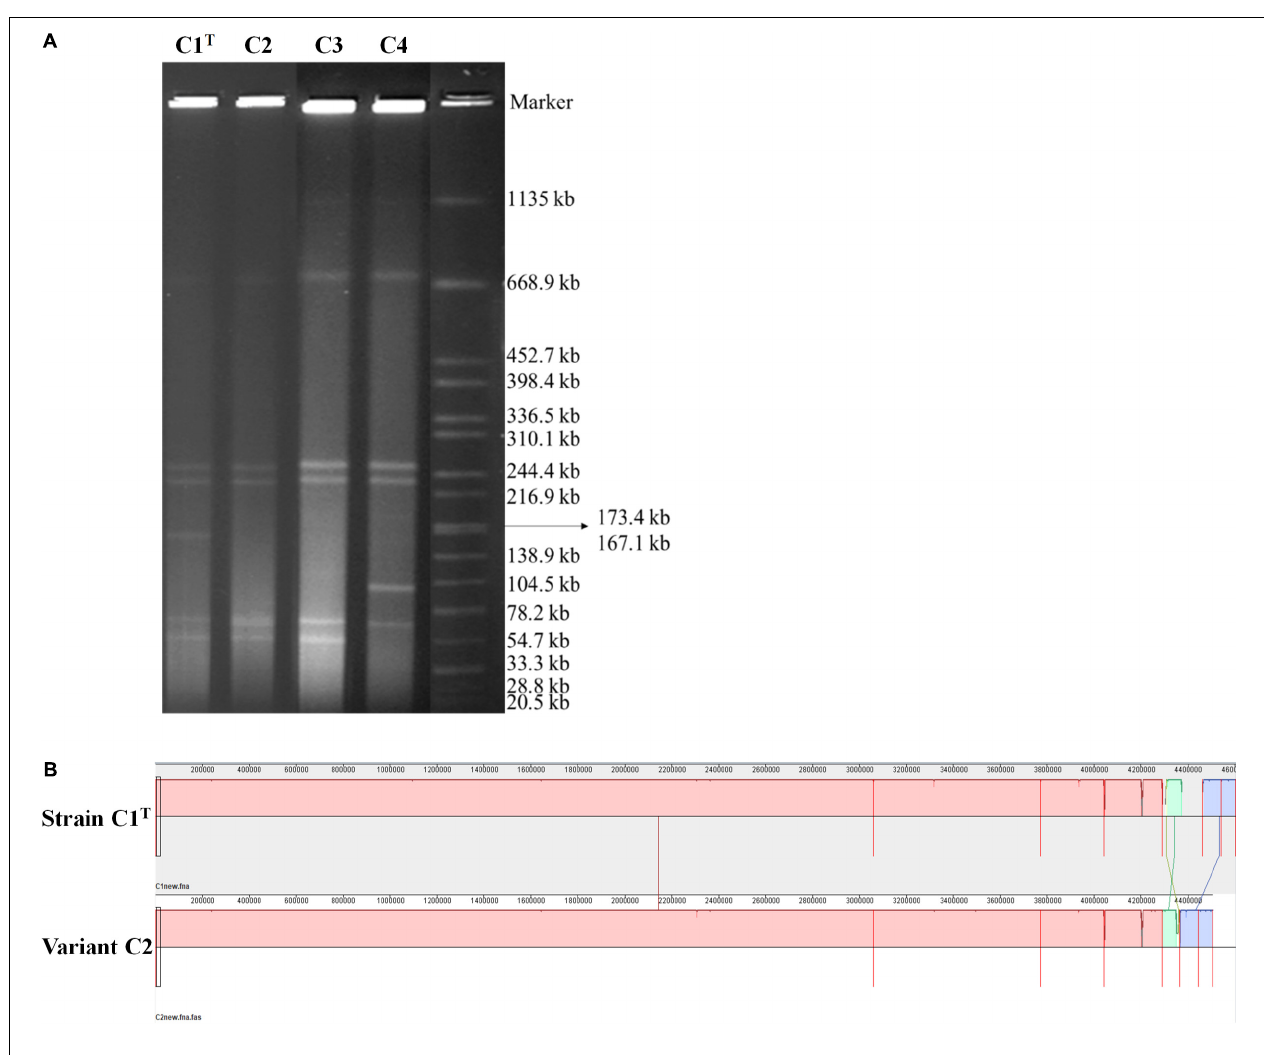
FIGURE 5 | The genomic differences between strain C1 T and its variants. (A) The genome profiles detected by PFGE. Salmonella enterica serovar Braenderup H9812 digested with Xba I was used as a size marker. (B) Genome alignment of strains C1 T and C2 by